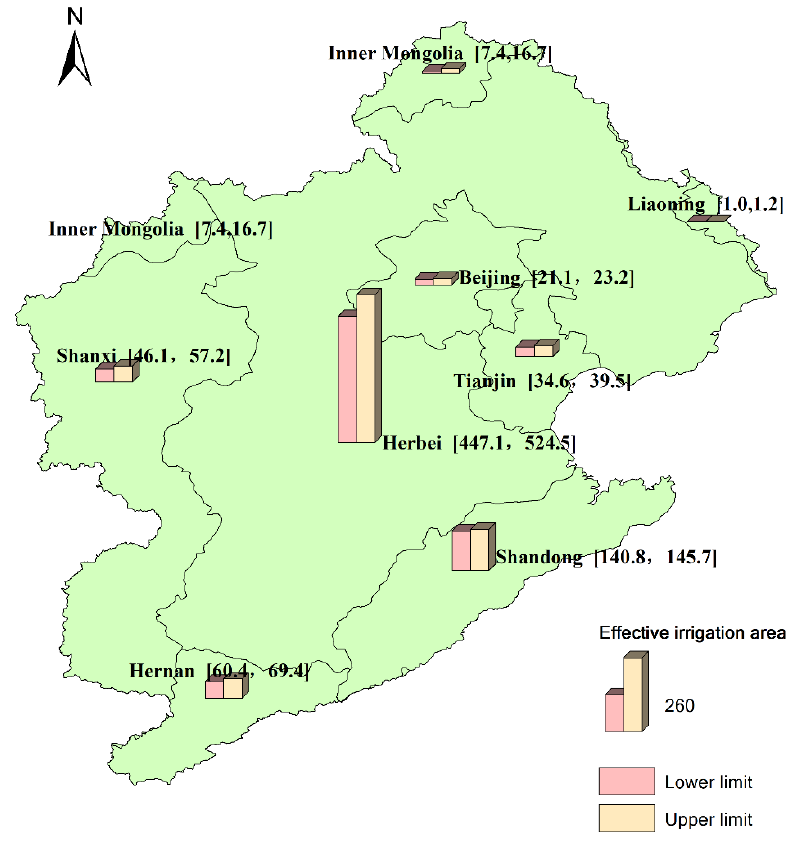
Figure 5. Optimization results of the effective irrigation area in the Haihe River Basin (10 4 ha).